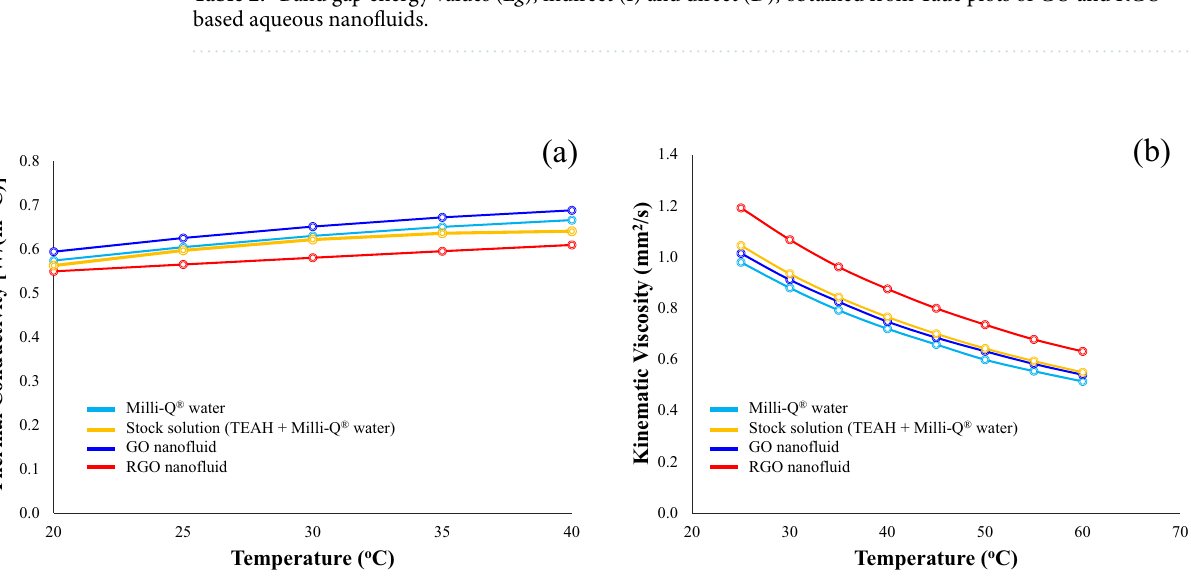
Figure 5. ( a ) Variation in thermal conductivity of GO and RGO nanofluids with temperature and ( b ) variation in nanofluid viscosity with